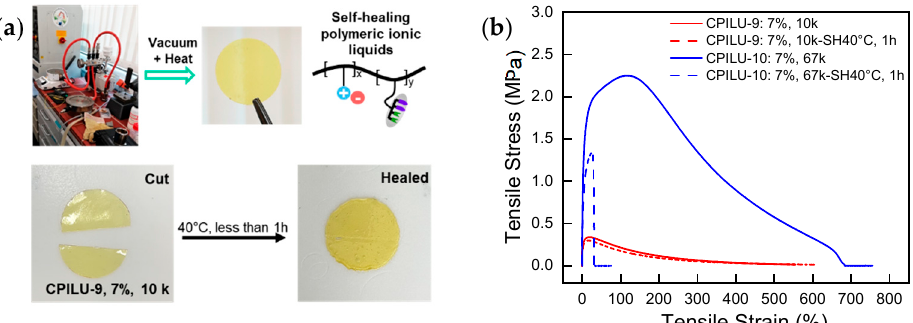
Figure 4. ( a ) Visualized self-healing of CPILU-9 ; and ( b ) stress–strain curves of pristine (solid line) and self-healed (at 40 °C for 1 h, dash line) CPILU-9 and CPILU-10 at a strain rate of 20 mm · min − 1 at room temperature.